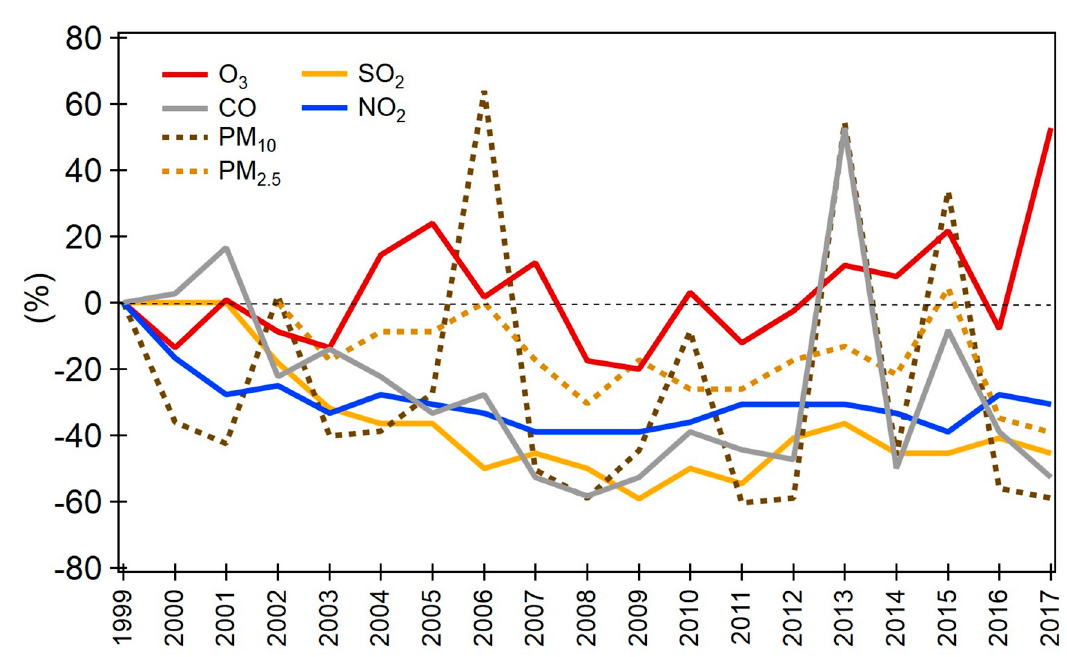
Figure 13. Percentage di ff erence of the annual mean concentration (PM 2.5 , NO 2 , and SO 2 ), 8-h annual maximum concentration (O 3 and SO 2 ) or 99th 24-h annual percentile concentration (PM 10 ) to respective concentrations of 1999, except for PM 2.5 , for which 2002 is the used as reference year. Years 2006, 2013, and 2015 were a ff ected by transboundary haze. Data were obtained from the Department of Statistics Singapore [39].